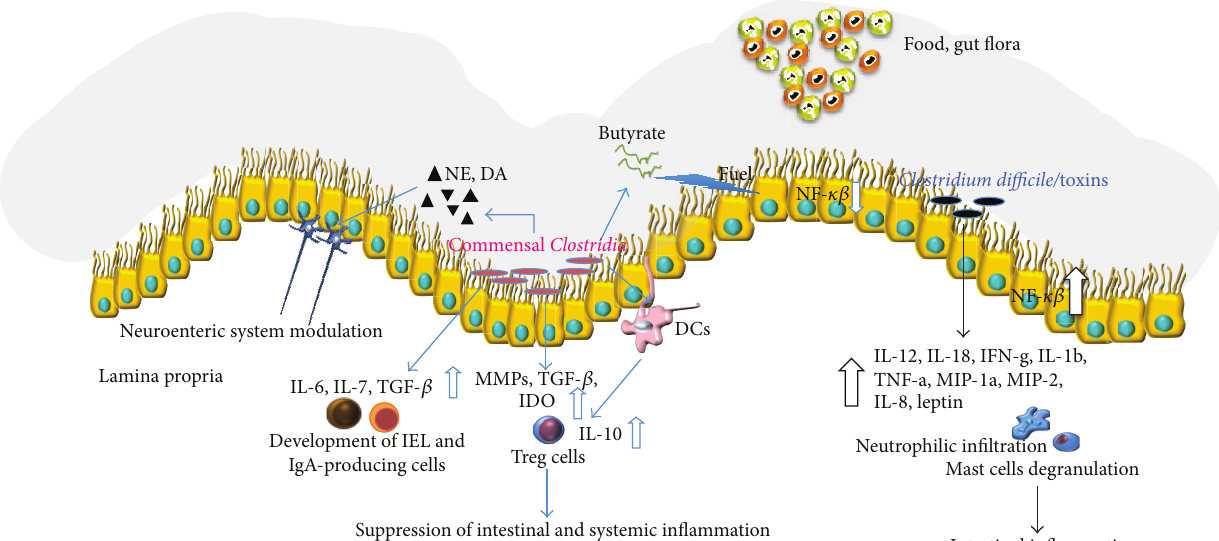
Figure 1: Commensal Clostridia have a peculiar role in modulating gut homeostasis. Establishing a close relationship with gut cells (interfold region), Clostridia spp. exert a strong influence on the host immune system. On the other hand, C. difficile and its toxins lead to the production of multiple proinflammatory cytokines and chemokines including IL-12, IL-18, interferon g (IFN-g), IL-1b, TNF-a, macrophage inflammatory protein 1 a (MIP-1a), MIP-2, IL-8, and leptin [66]. These factors can exacerbate the inflammation and may be responsible for host damage and many of the histopathological features of C. difficile -associated